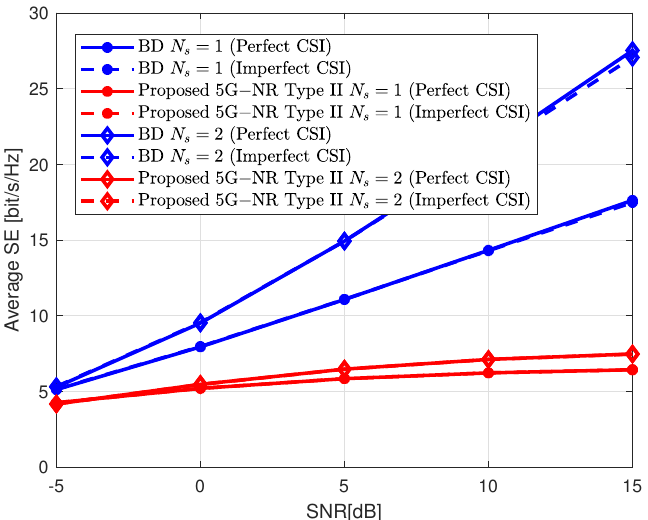
Figure 10. Average SE vs. SNR for MU-MIMO systems assuming 𝐾 = 2, 𝑁 𝑡 = 32, 𝑁 𝑟 = 4, and different values of 𝑁 𝑠 . The gNB is implemented assuming a single-panel UPA with 𝑁 1 = 4, and 𝑁 2 = 4. Imperfect CSI is also assumed with 𝜎 2 𝑒 = 10 − 3